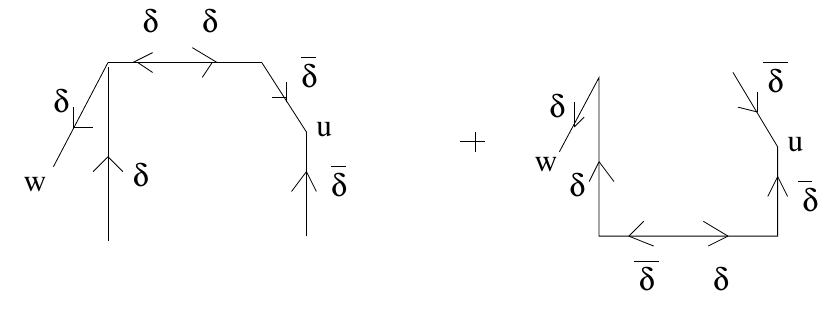
Figure 18 . Skeleton graphs for (cid:8) 23 ;B